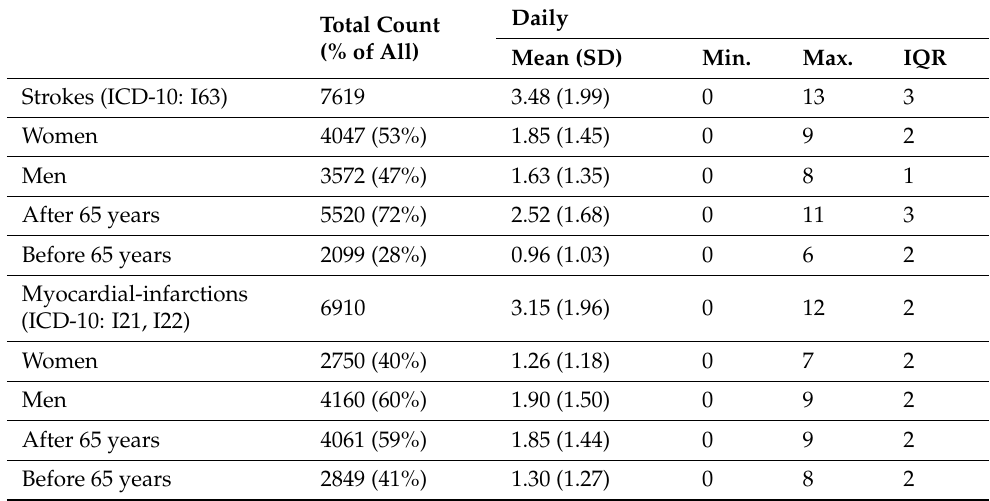
Table 1. Summary of daily hospital admission for strokes (I63) and myocardial infarctions (I21, I22) in the Gdansk agglomeration in the years